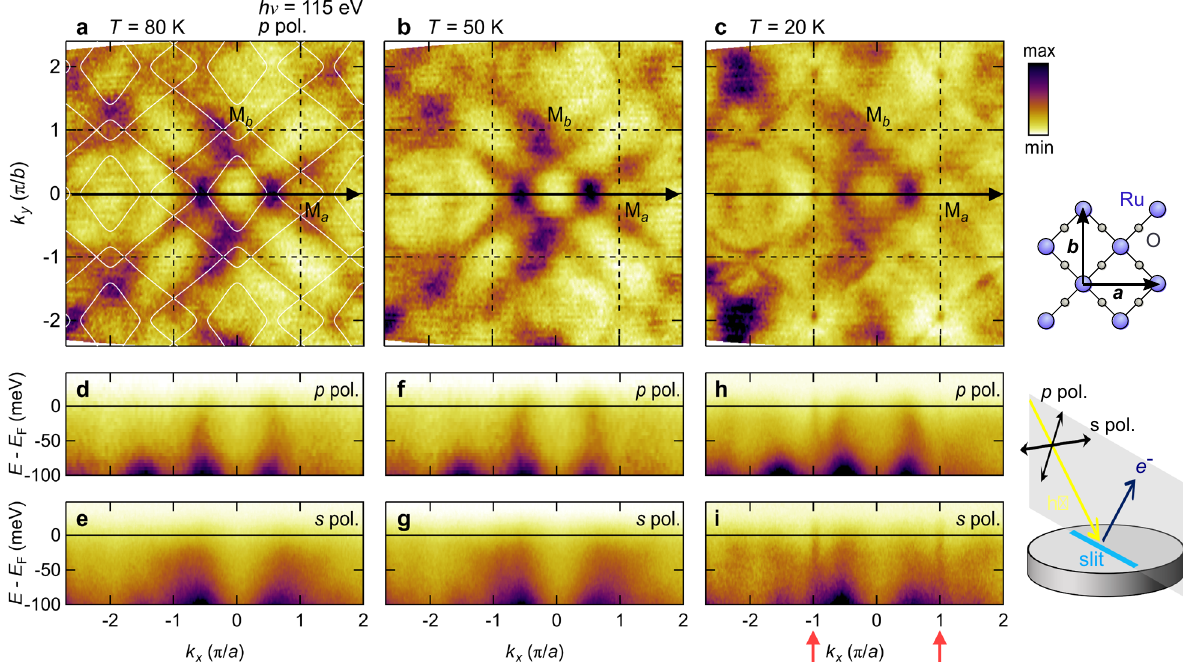
Fig. 1 Fermi-surface reconstruction in Ca 3 Ru 2 O 7 . a – c Fermi surface maps taken at T = 80, 50, and 20 K, respectively. The photoelectron intensities -- displayed using a false color scheme — are integrated within E F ± 20 meV. White lines in a represent a tight-binding model (see Supplementary Note 1 and Supplementary Fig. S1) of the Fermi surface. Vertical and horizontal dashed lines indicate the orthorhombic zone boundaries. The orthorhombic a and b axes are indicated in top right inset. d – i Energy distribution maps along the Γ – M a direction for incident light polarisations and temperatures as indicated. Red arrows mark the fast dispersing bands that emerge below T s1 = 48 K. The photoemission mirror plane along with incident light polarisation and the orientation of the electron analyser slit is shown in the bottom inset. With this setting, matrix elements for even-parity orbitals are expected to be suppressed in the s -polarisation